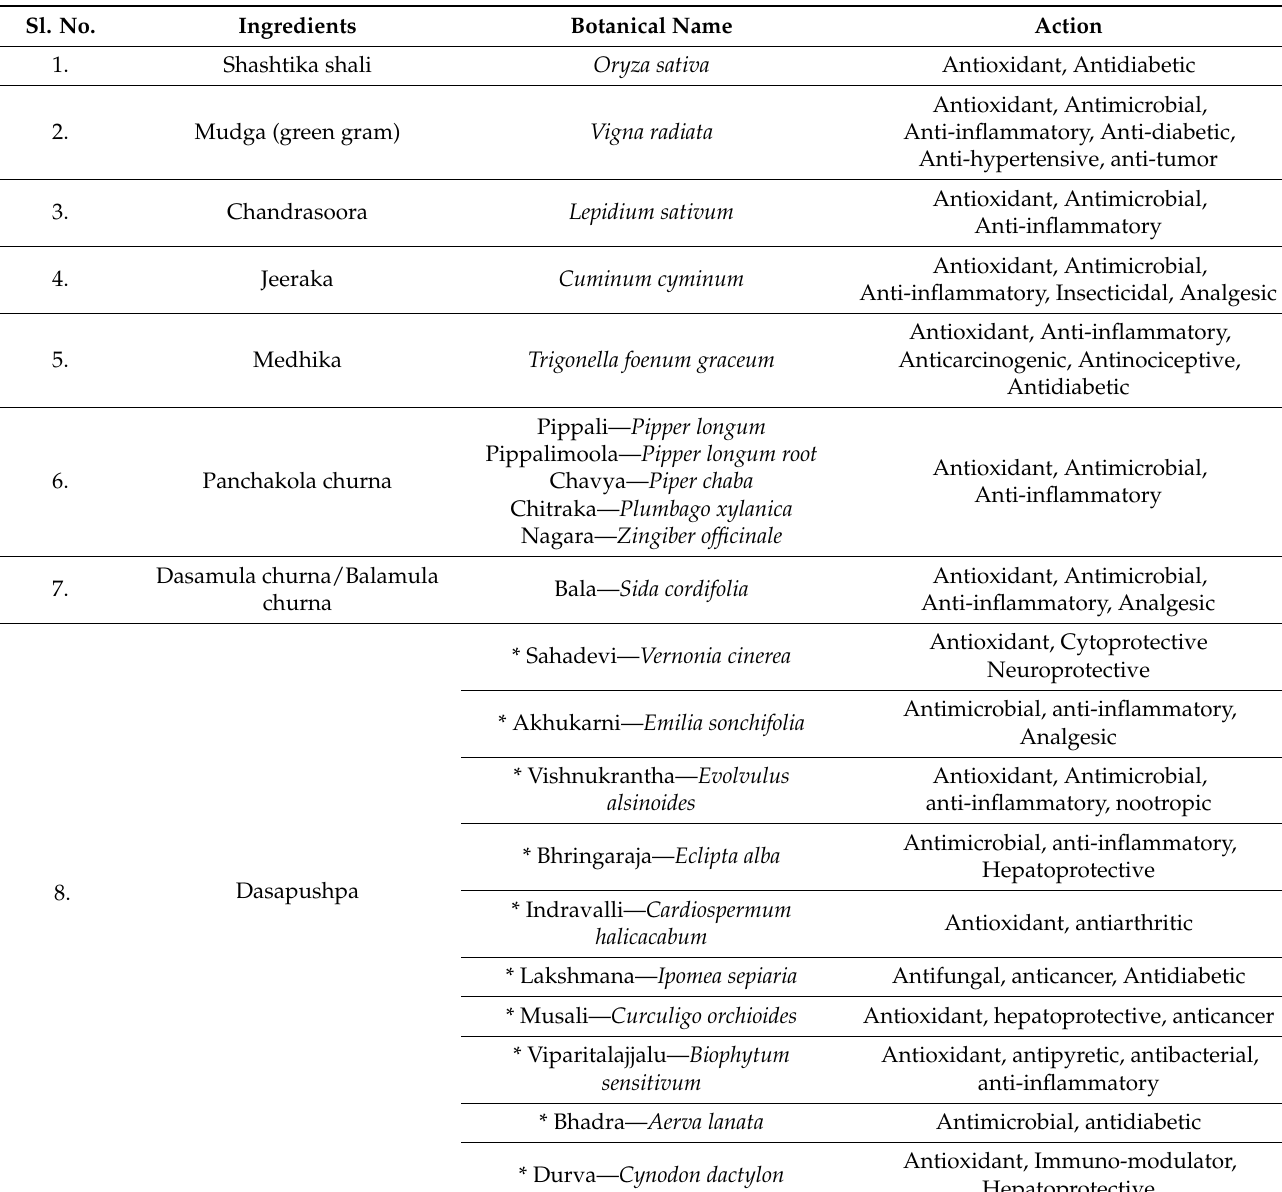
Table 2. Ingredients and action